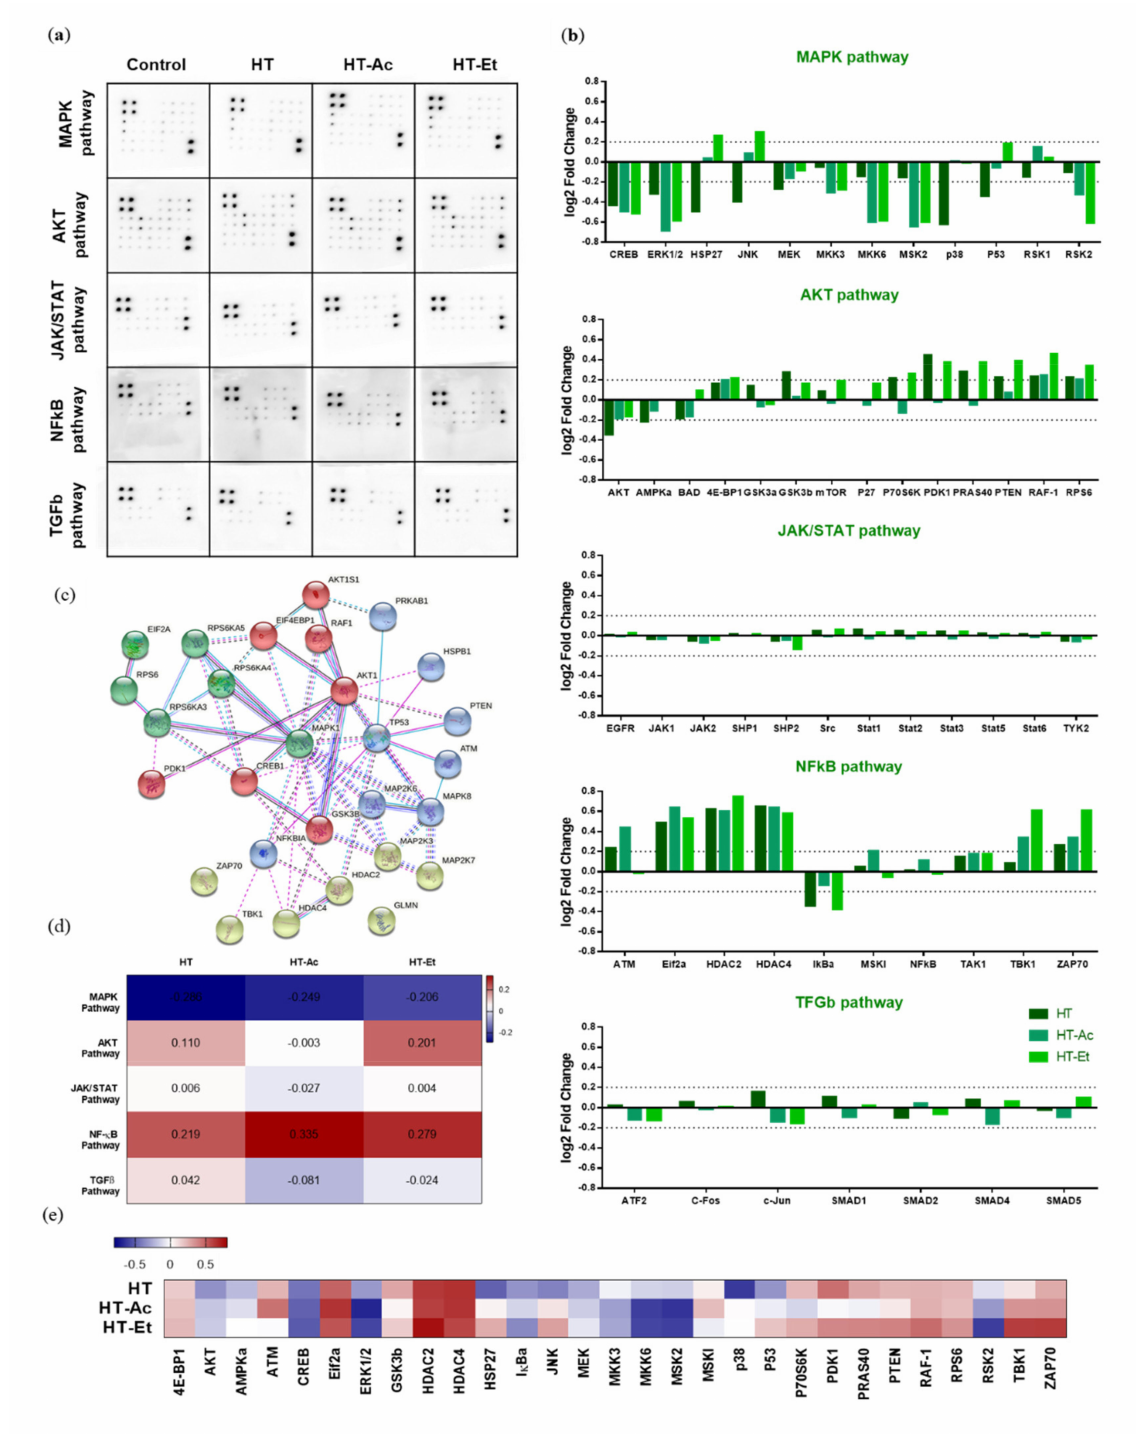
Figure 5. Effect of HT, HT-Ac, and HT-Et treatment (10 µ M, 24 h) in the phosphorylation of key proteins in cancer-related pathways in 22Rv1 cells. ( a ) Membranes showing the spots quantified to study the phosphorylation level of 55 proteins in the phosphoprotein array (5 oncogenic pathways; 55 phosphorylated proteins) in response to 24 h treatment HT, HT-Ac, and HT-Et ( n = 4; pooled). ( b ) log2 Fold Change of phosphorylation protein level in comparison with the control (DMSO) condition (threshold: log2 Fold Change = 0.2). ( c ) The significantly altered phosphorylated proteins were analyzed using the STRING database. ( d ) Heatmap showing the log2 Fold Change mean corresponding to each pathway. ( e ) Heatmap showing the log2 Fold Change of selected altered proteins. Abbreviations: HT, Hydroxytyrosol; HT-Ac, hydroxytyrosyl acetate; HT-Et, ethyl hydroxytyrosyl